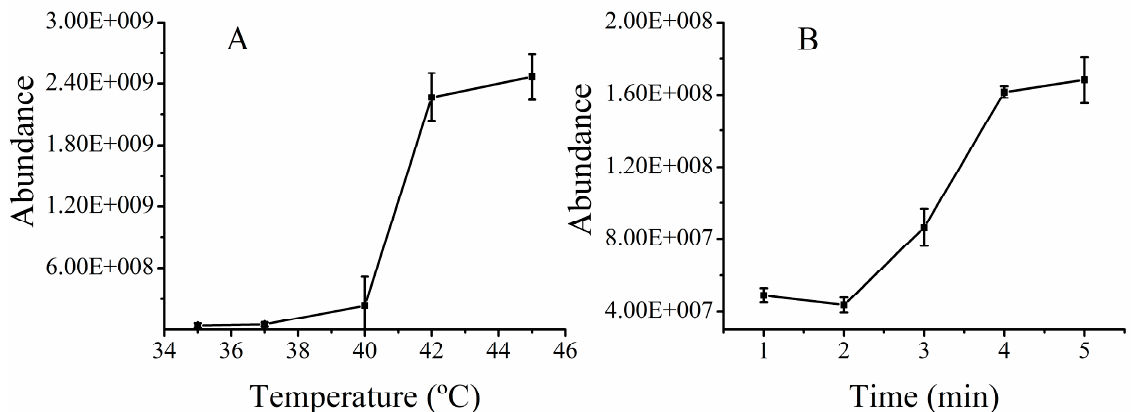
Figure 3. Optimization of the temperature and heating time for the destruction of liposomes: Peak areas of tetrahydropal- matine (THP) released from BMLs at different temperatures for 4 min ( A ). Peak areas of THP released from BMLs at 42 °C with different heating times ( B ).